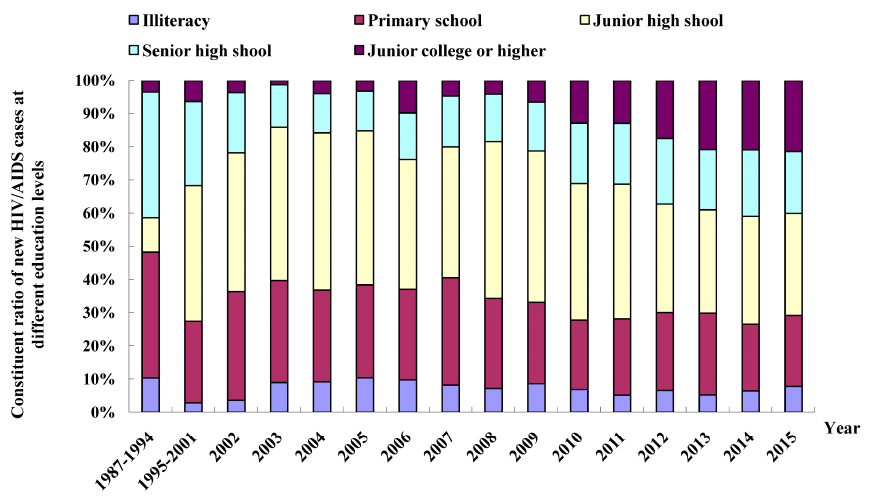
Figure 5. Distribution of new HIV/AIDS patients by education level in Fujian Province from 1987 to 2015.